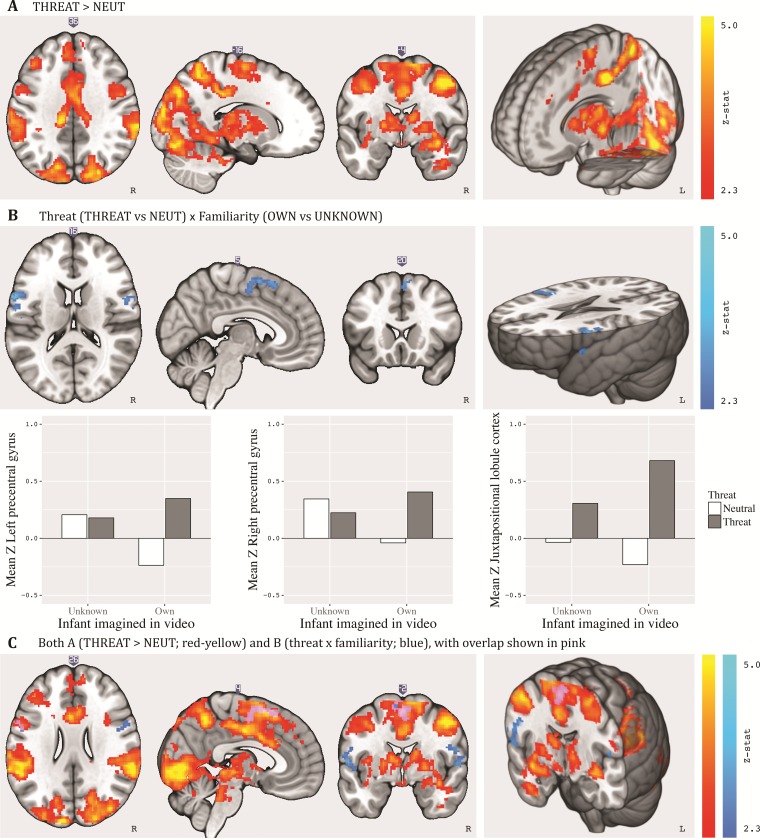
Activation for (A) main effect of threat, (B) interaction between threat and familiarity and mean Z-values for the interaction between threat and familiarity in the left pre-central gyrus, right pre-central gyrus and juxtapositional lobule cortex, (C) combination of A and B. Results (cluster-thresholded at 2.3, P < .05) are displayed on MNI-normalized template brain (i.e. mni152_2009bet.nii) using MRIcroGL software.